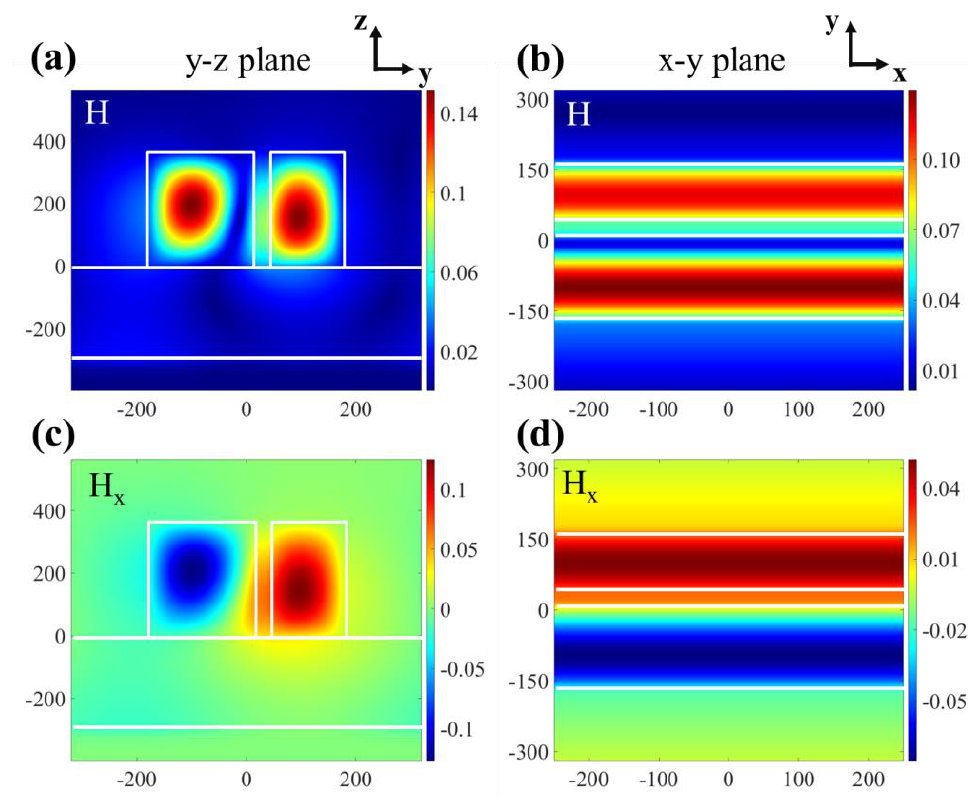
Figure 3. The magnetic field distribution at the peak of the Fano resonance spectral curve: ( a ) at y-z plane, ( b ) at x-y plane. The magnetic field in x-direction normalized to the field amplitude of the incident light: ( c ) at y-z plane, ( d ) at x-y plane.